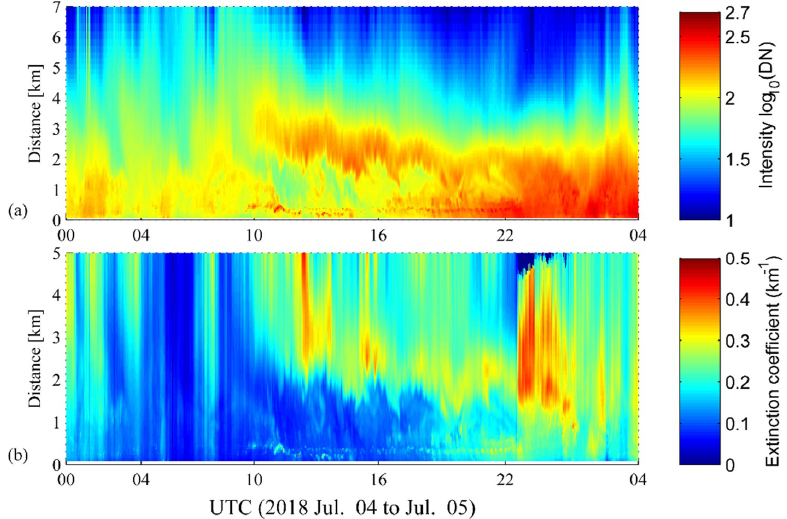
Figure 4 Temporal-spatial map of the ( a ) received signal intensity and ( b ) the atmospheric extinction coefficient. The measurements were performed on a near horizontal path with an elevation angle of 5 ° . Location of the lidar system: 38°52'46.4"N 121°31'42.1"E. The local times is 8 hours ahead of